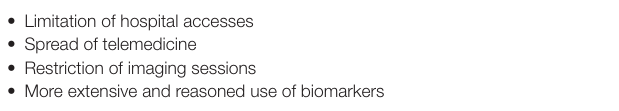
TABLE 2 | The four pillars of